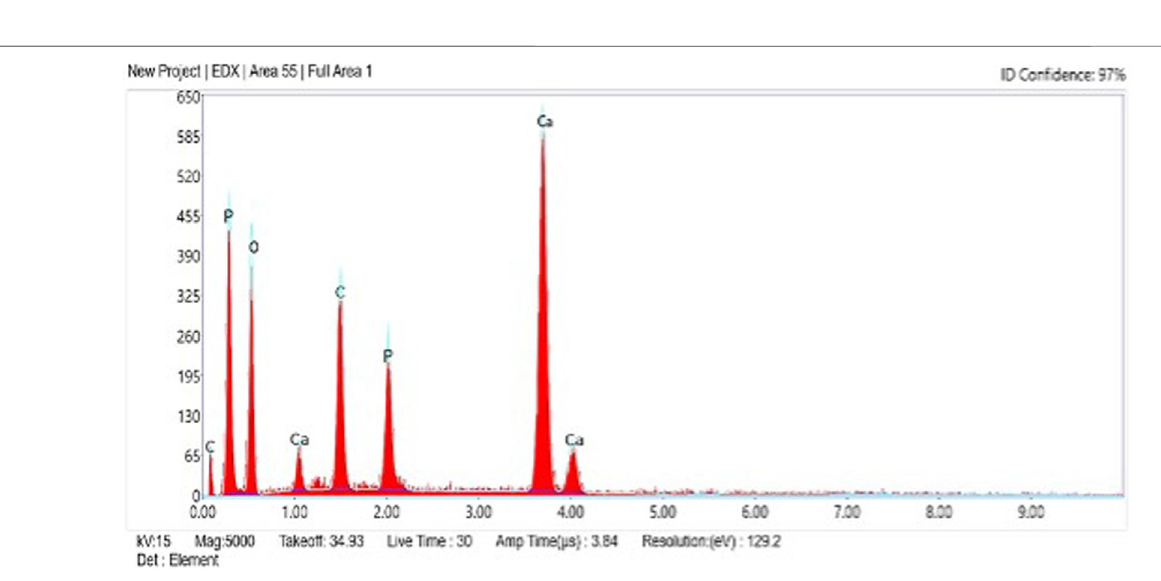
FIGURE 3 | EDX spectra showing the elements present in as-prepared HAp